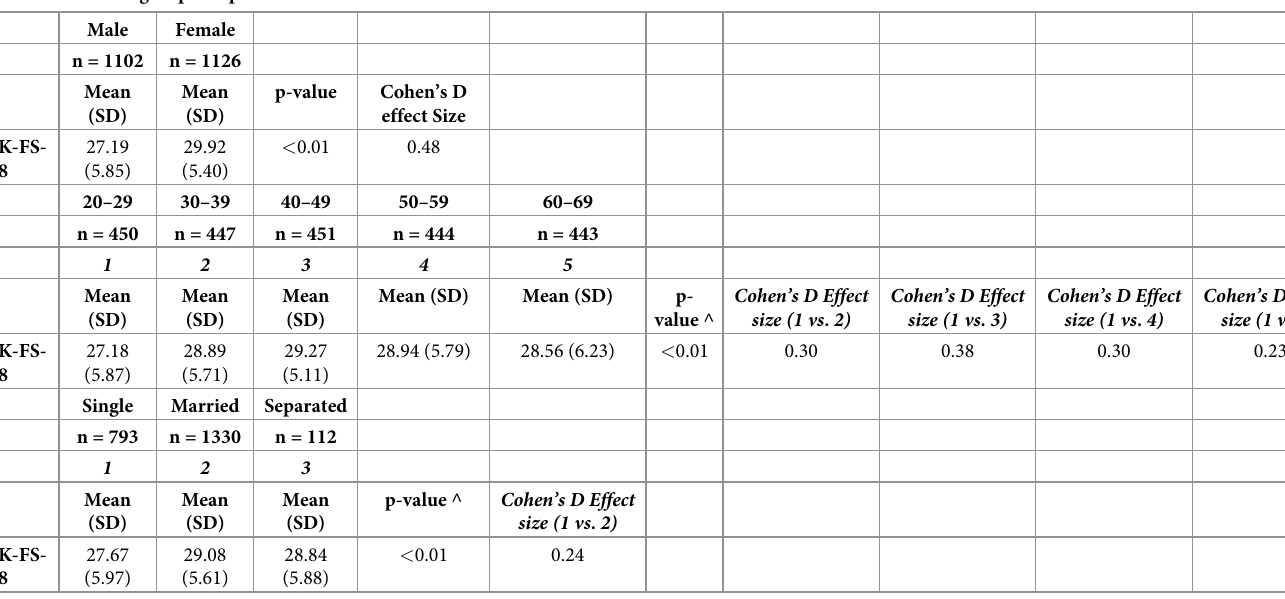
Table 3. Known-group comparison.